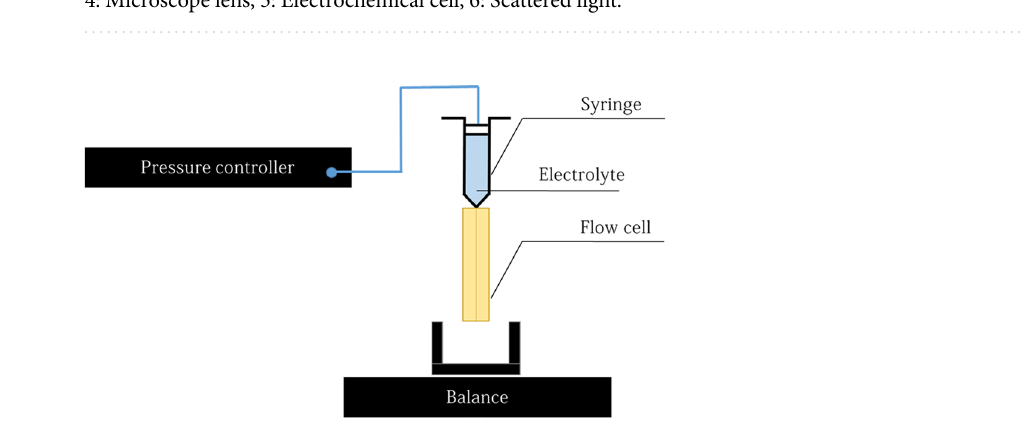
Figure 12. Scheme of the experimental set up used to measure the viscous